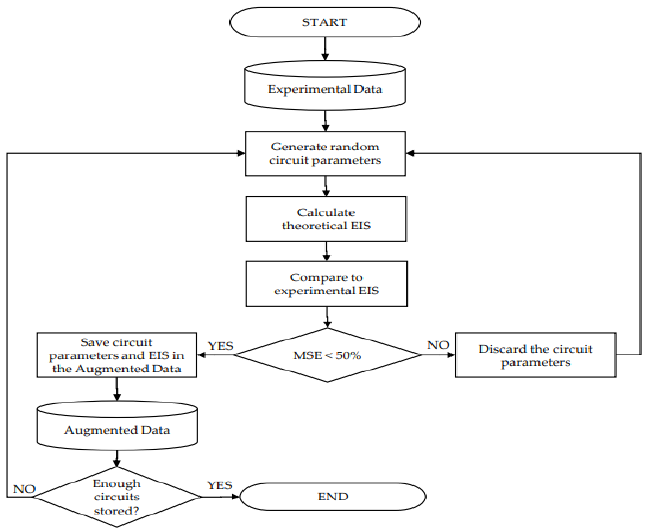
Batteries 2022 , 8 , x FOR PEER REVIEW Figure 3. Data augmentation detailed flowchart. Figure 3. Data augmentation detailed flowchart.